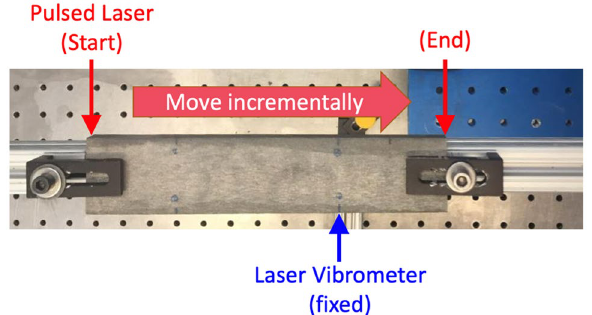
Figure 2. Setup for the seismic experiments on the 3D printed model. Thin arrows show the locations of the laser source (red) and receiver (blue). Thick red arrow shows the direction at which the laser is scanned along the top side of the